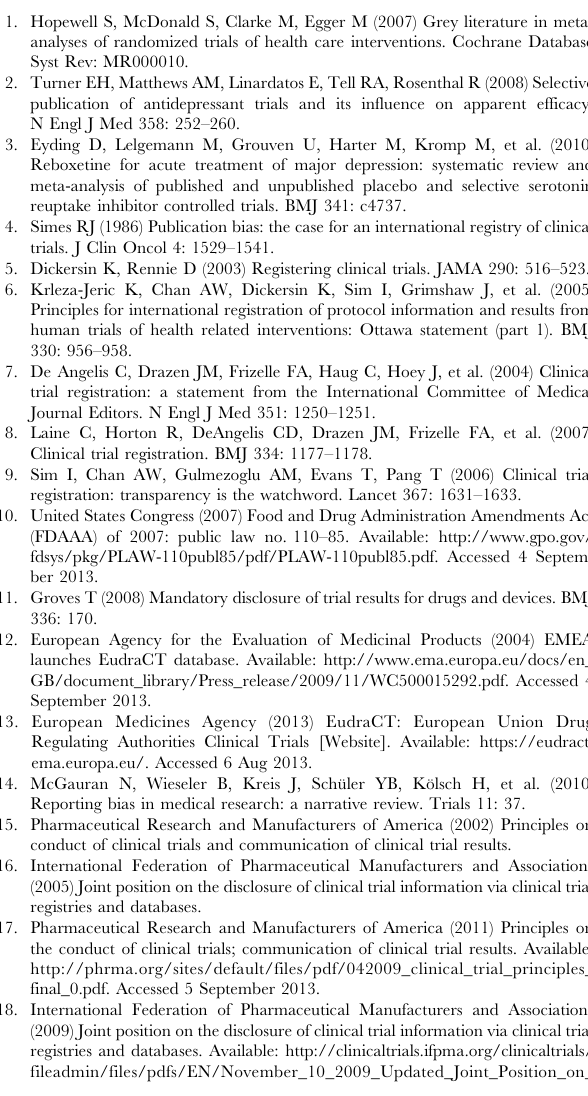
Table S1 Search strategy for identifying systematic reviews of drugs in Medline (OVID).